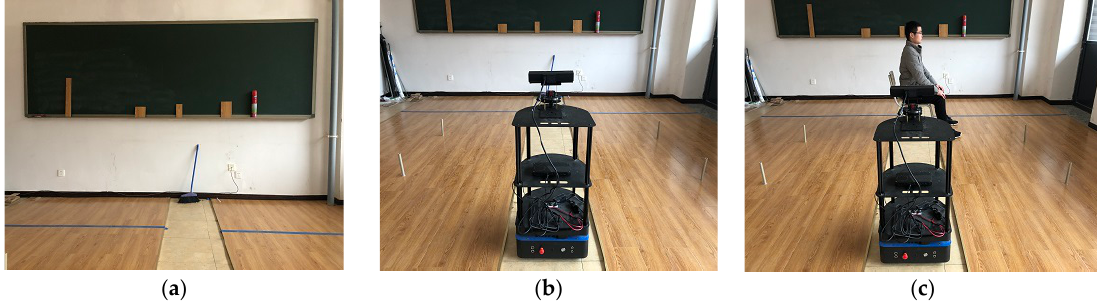
Figure 6. Scene of the restore mapping experiment. ( a ) The experimental environment we designed; ( b ) the state of robot and experimental environment before adding changes; ( c ) the state of robot and experimental environment after adding changes.